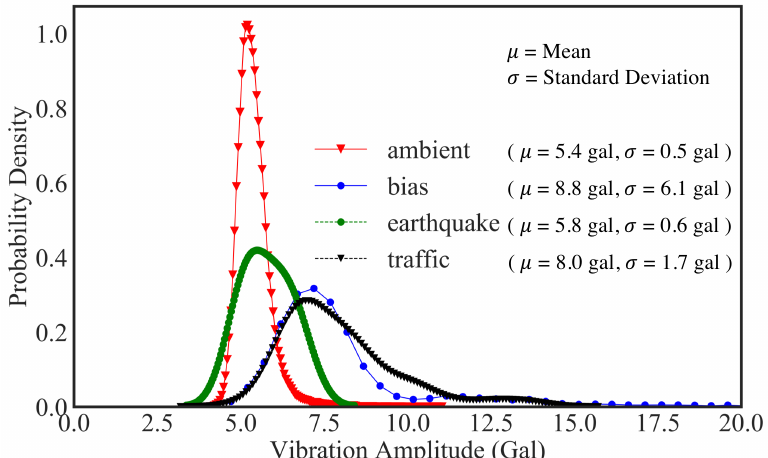
Figure 21. Probability density function plot of vibration amplitude for di ff erent classes of predicted